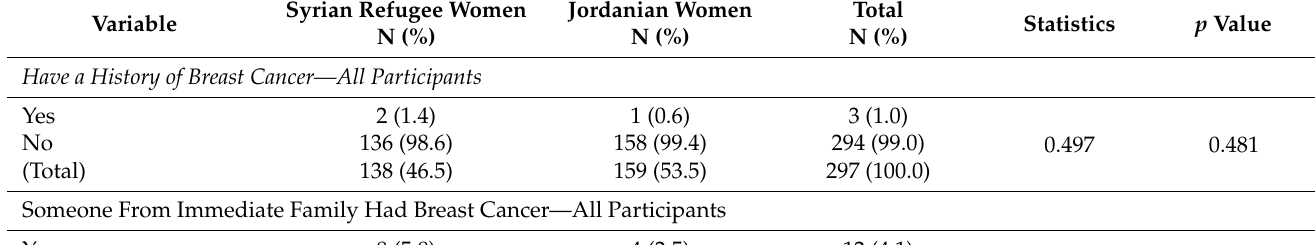
Table 2. Breast cancer history and screening practices among Syrian refugee women and Jorda- nian